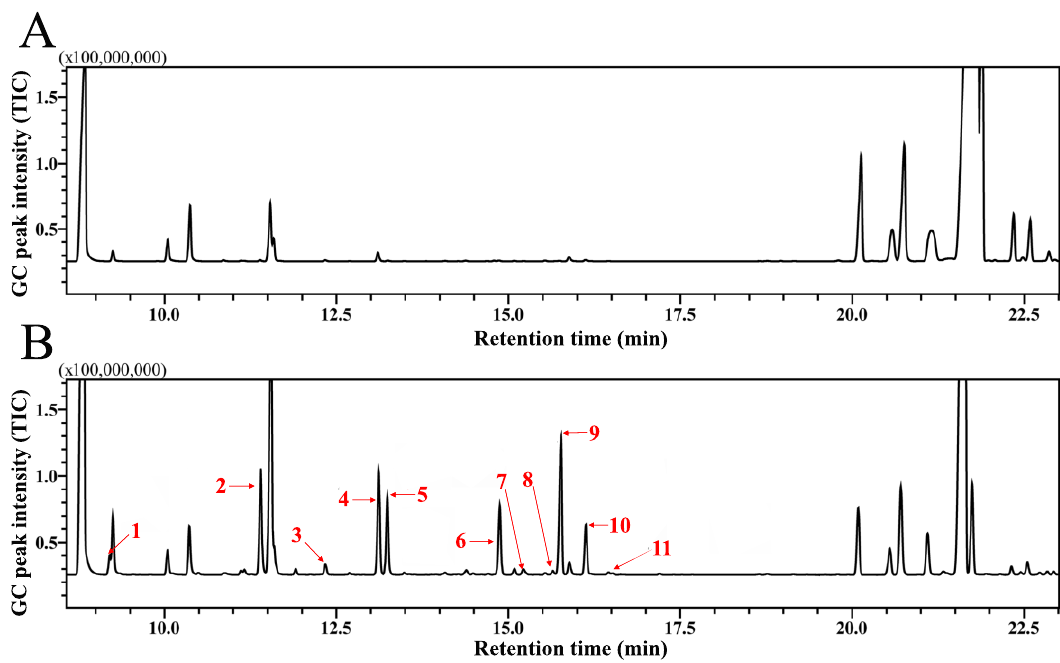
Figure 1. GC – MS chromatograms of Pinus massoniana volatiles. ( A ) The GC – MS chromatograms of healthy P. massoniana wood sections. ( B ) The GC – MS chromatograms of infested P. massoniana wood sections caused by M. alternatusC ; the HIPVs were marked by red arrows with the number corresponding to Table 1. Table 1. Information of HIPVs from infested Pinus massoniana Lamb.